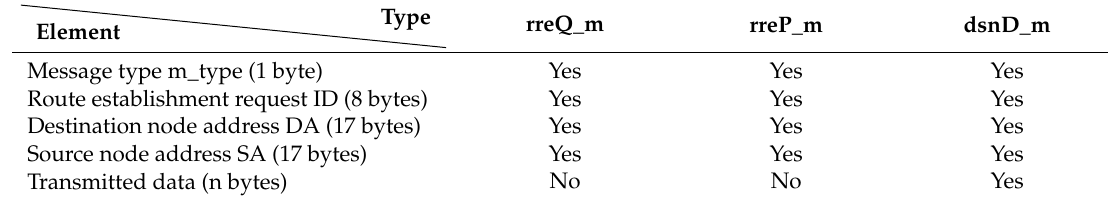
Table 4. Message types and elements route establishment request (rreQ_m); route establishment